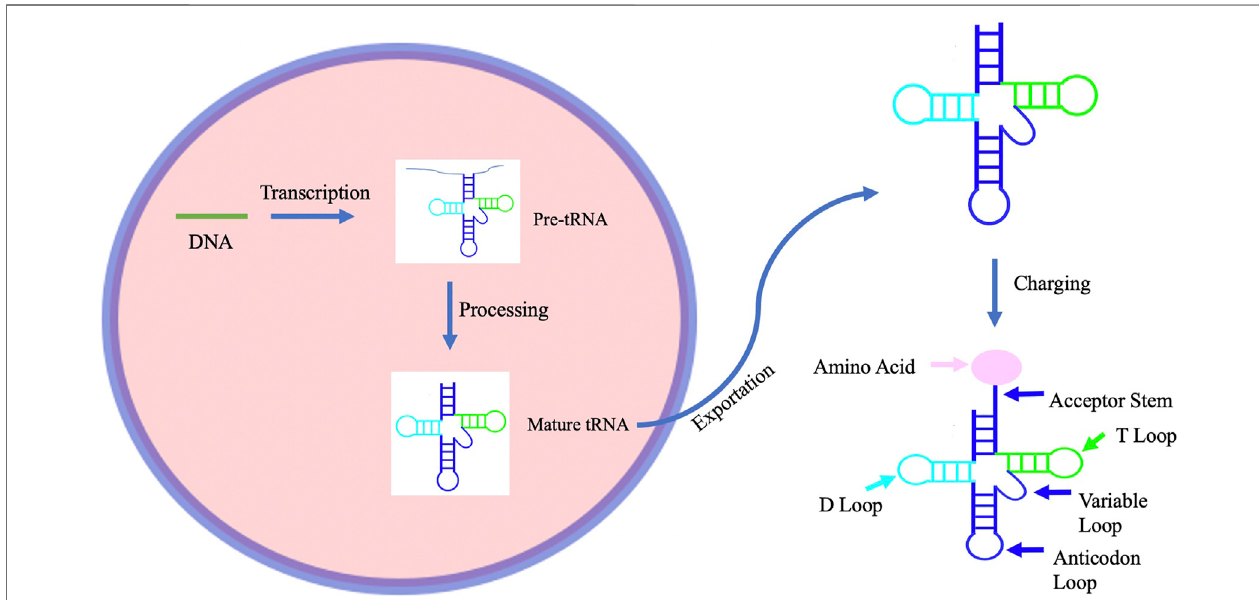
FIGURE1 | Aschematic representation ofthe process oftRNA biogenesis. tRNA biogenesisbegins with transcription oftRNA to form pre-tRNA. This pre-tRNA is then processed to form a mature tRNA before being exported from the nucleus. The mature tRNA is then ready to be charged with an amino acid by an aminoacyltRNA